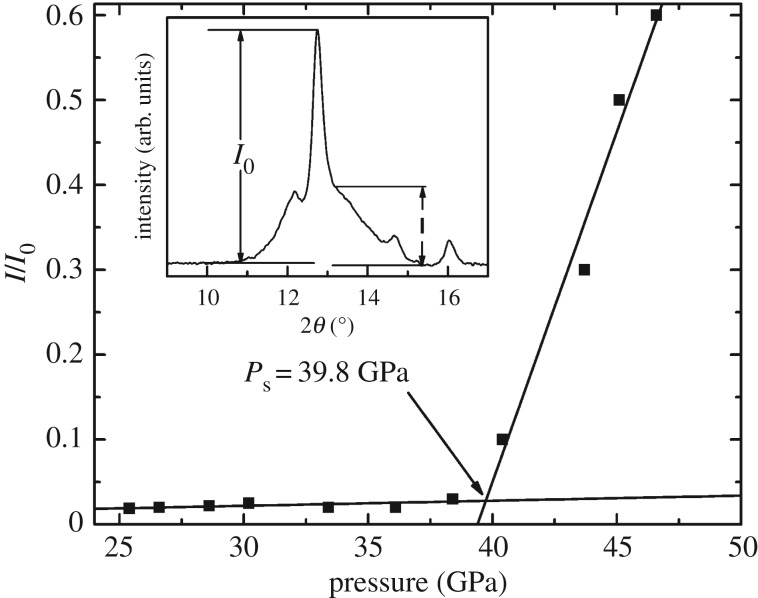
The intensity ratio between (222) of the pyrochlore and cotunnite phase as a function of pressure. Cotunnite intensity is defined as the intensity between the (222) and (004) pyrochlore reflections.